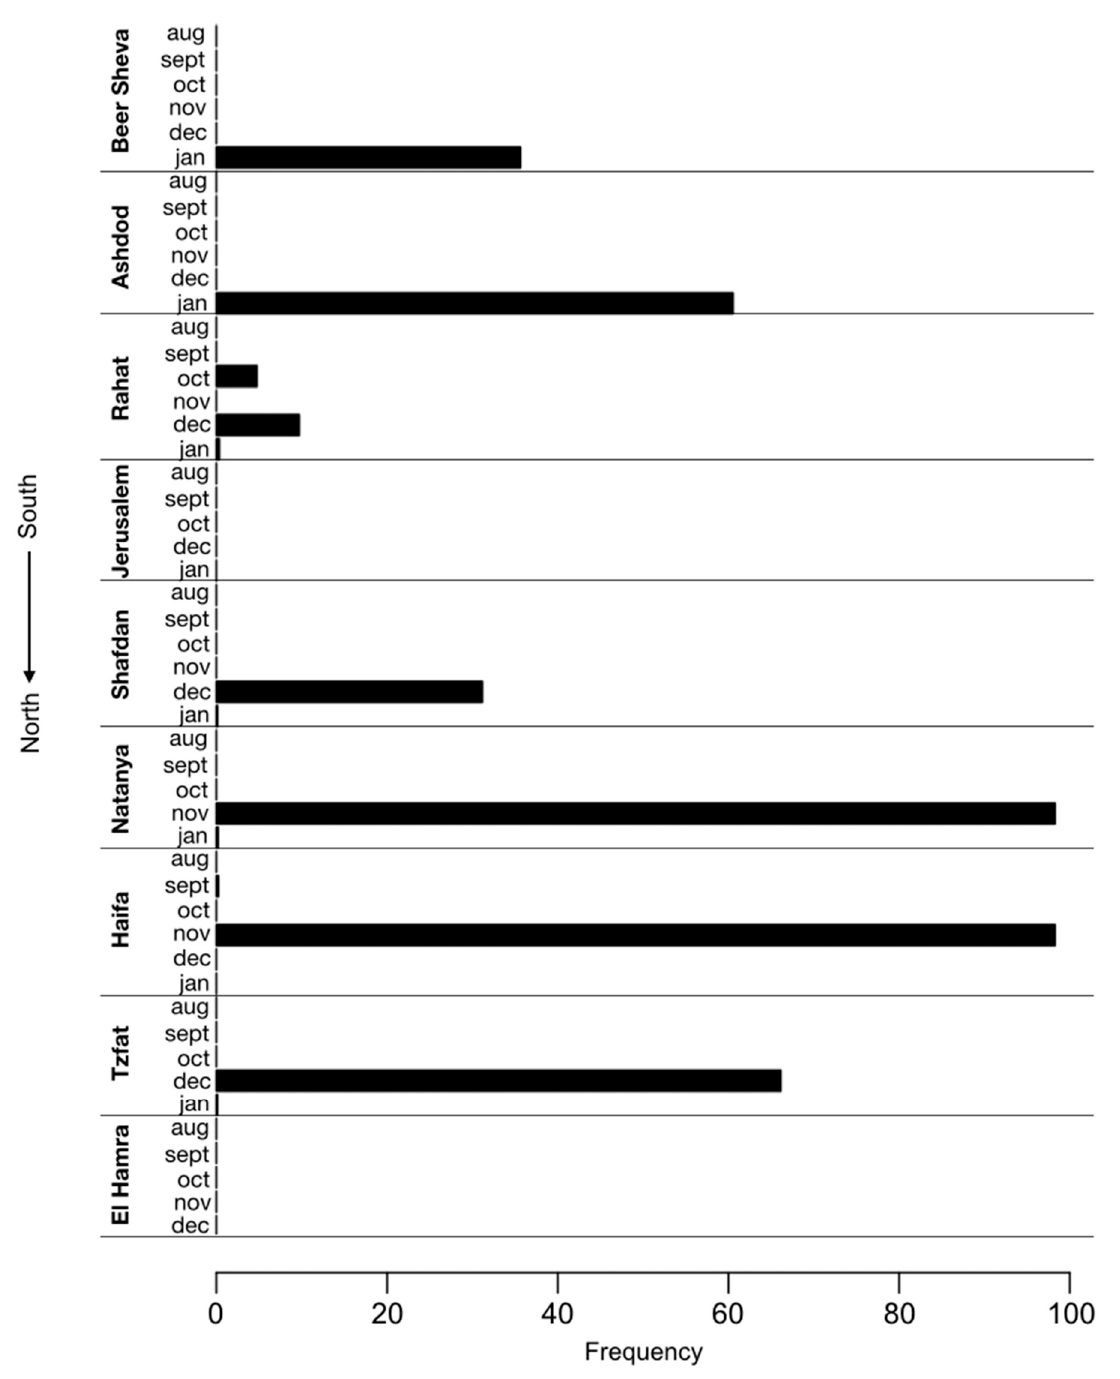
Figure 2. Identification of the P681H mutation in sewers across Israel. Frequency of P681H mutation in SARS-CoV-2 genomes sequenced from nine sewage samples of wastewater treatment plants across Israel each month in August 2020–January 2021. The frequency of the P681H mutation in each region was estimated by measuring the fraction of the mutation from the total number of nucleotides mapped at this position (i.e., depth of sequencing).